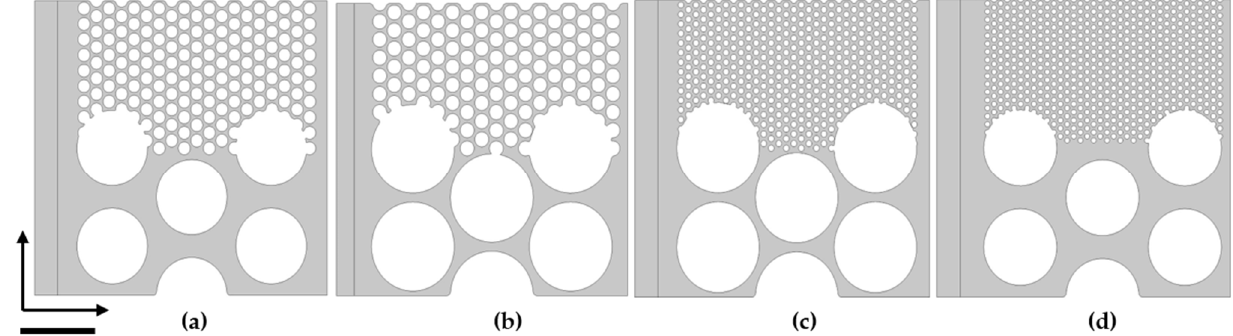
Figure 2. Final geometric model diagram ( a ) is chip 1; ( b ) is chip 2; ( c ) is chip 3; and ( d ) is chip 4. The scale bar is 1 mm.